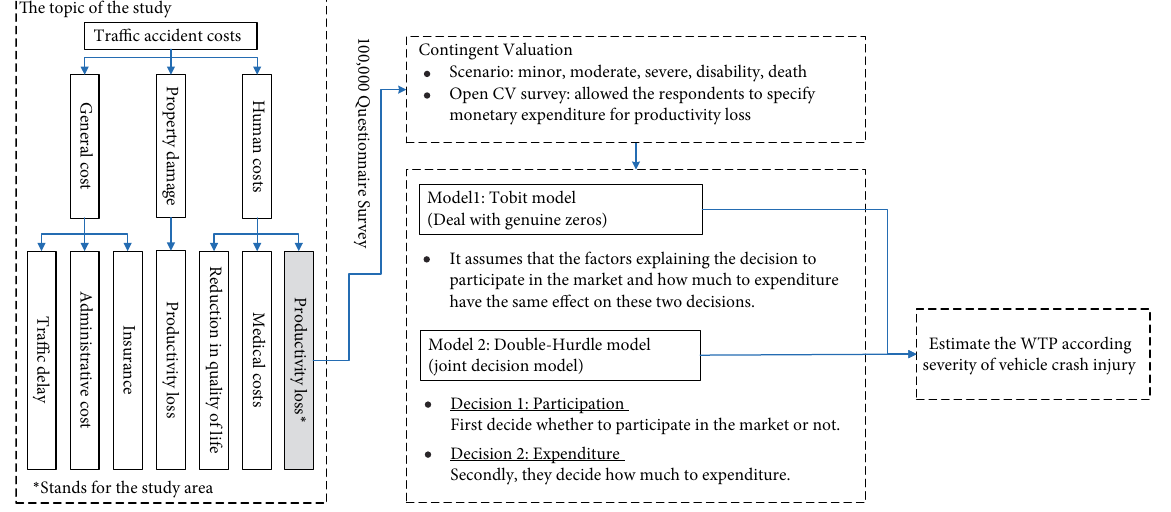
Figure 1: The comprehensive framework of the